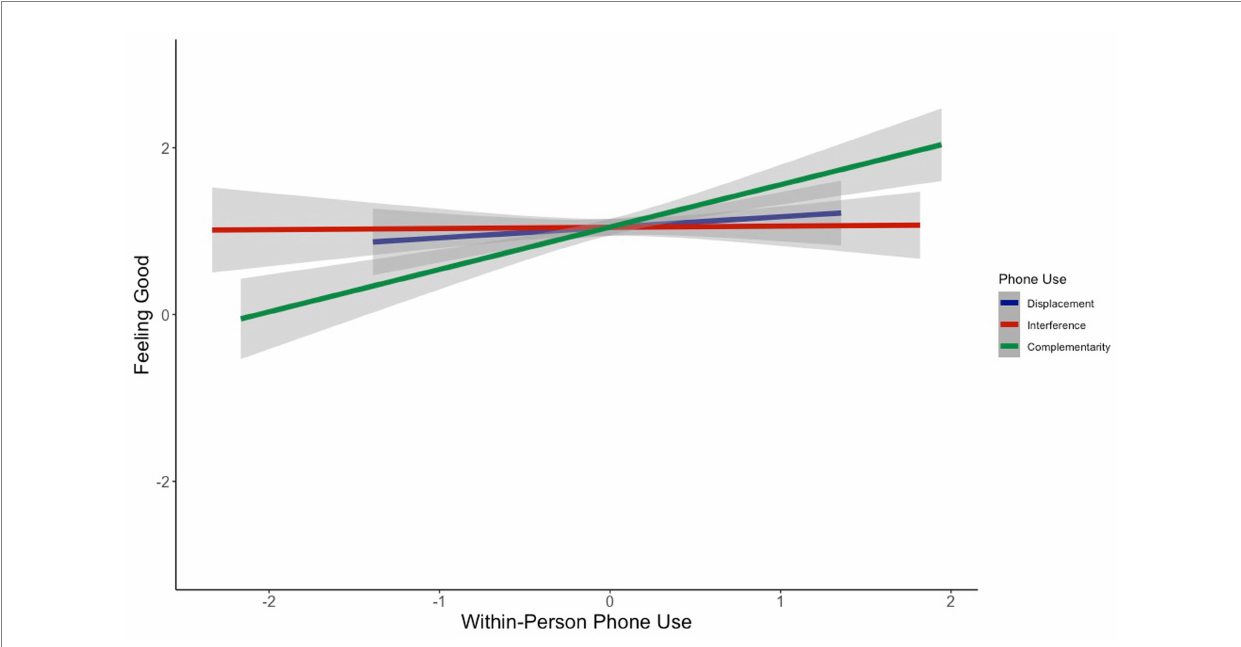
FIGURE 1 Association between within-person phone use and feeling